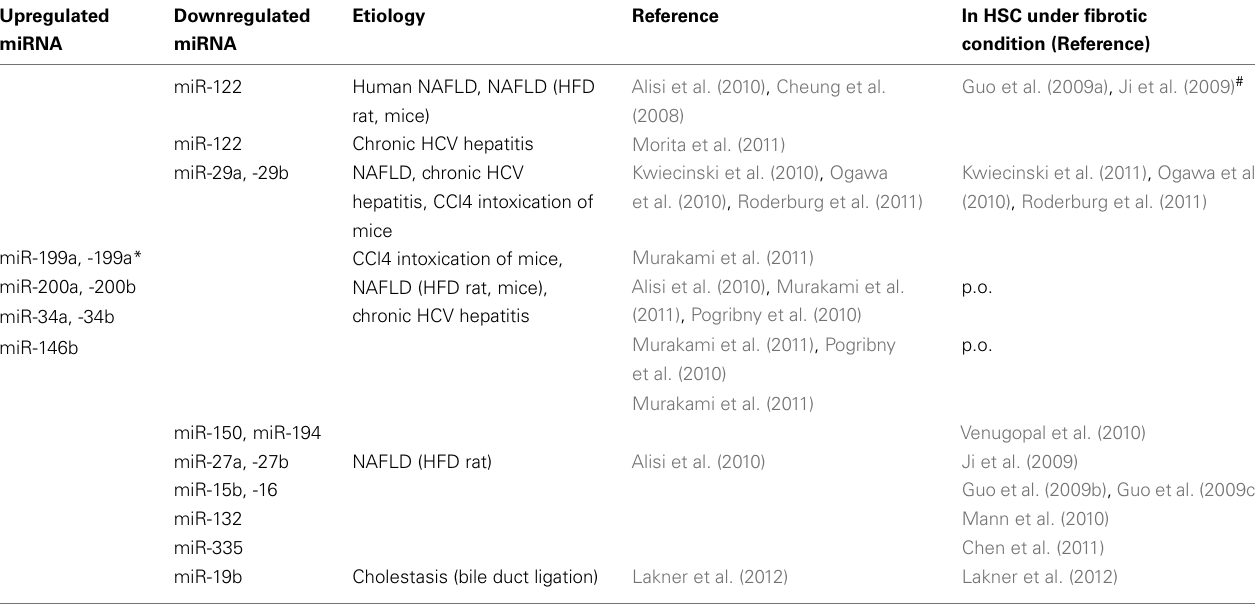
Table 1 | Dysregulated miRNA during liver fibrosis and myofibroblastic HSC activation.